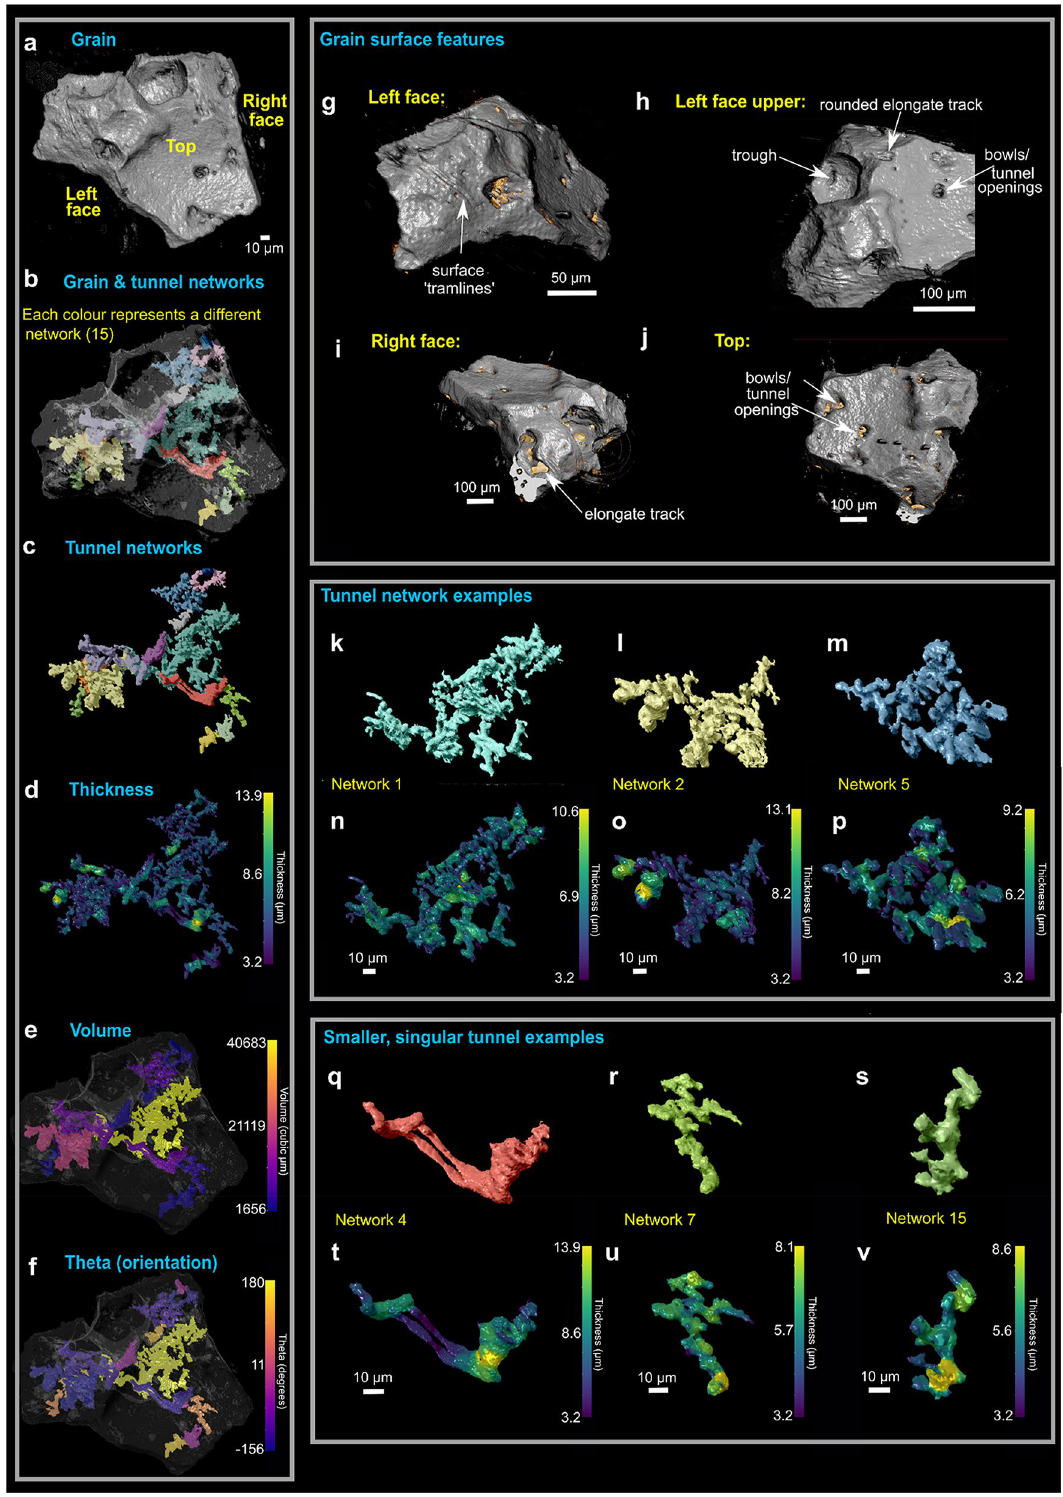
Figure 2. 3D analysis of the segmented tunnel networks from the grain of interest. (a-f) The entire grain tunnel networks including each individual network segmented as its own colour (a, b), tunnel thickness variations (d) , volume variations (e) , and orientation variations (f) . Grain surface features also shown (g-j); features include surface holes, tramlines, troughs, bowls, and rounded elongate tracks. Gold colour indicates accumulation of organic material. From analysis, there appears to be larger tunnel networks (k-p) and those that are more singular (q–v) ; variations in thickness through the tunnels are shown. Also see Supplementary Video